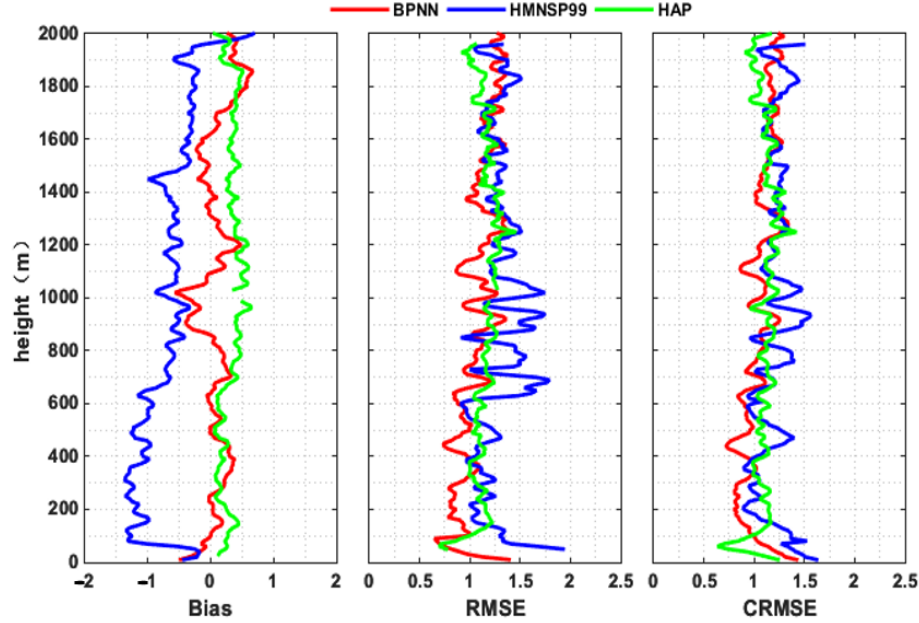
Figure 6. Overall statistical analysis of lg C 2 n profiles of 32 balloon